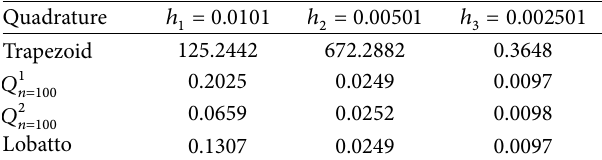
with . (a) Mesh with 0.00501. (b) Mesh with 𝑎(𝑥) 𝑚 = 400 ℎ = and . Example 1. Table 3: Relative error for different meshes. Example 𝑚 ℎ